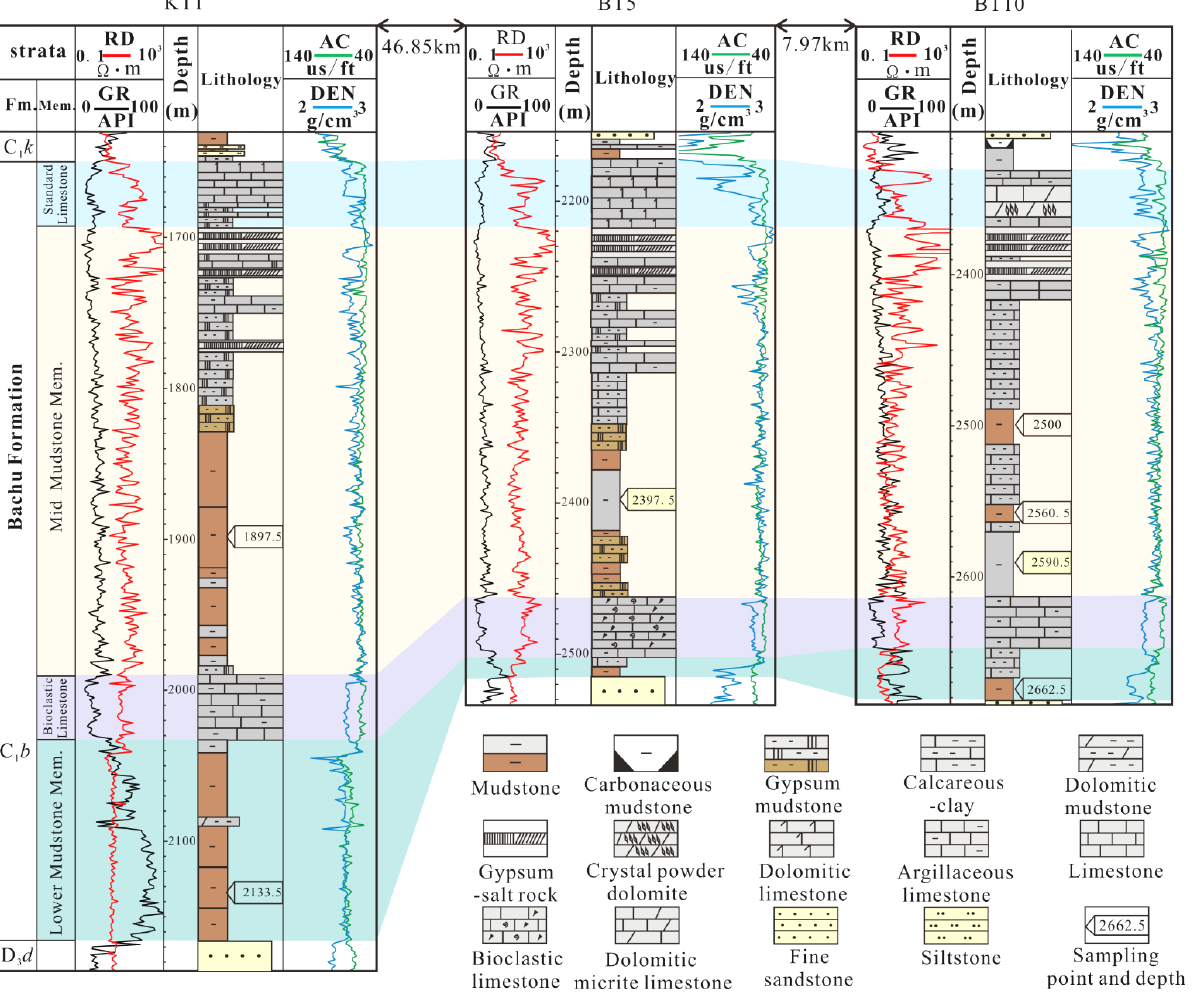
Figure 7. Profile of wells KT1, BT5, and BT10 of the Bachu Formation. See Figure 1b for the lateral positions. In the legend, the different colors filled by mudstone and gypsum mudstone reflect different sedimentary backgrounds, in which brown represents the oxidation environment and gray represents the reduction environment.